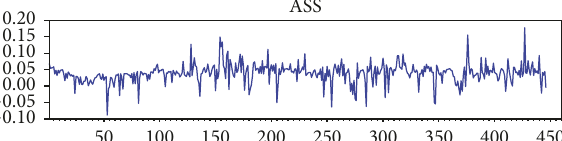
Figure 7: Asymmetry perception evolution in